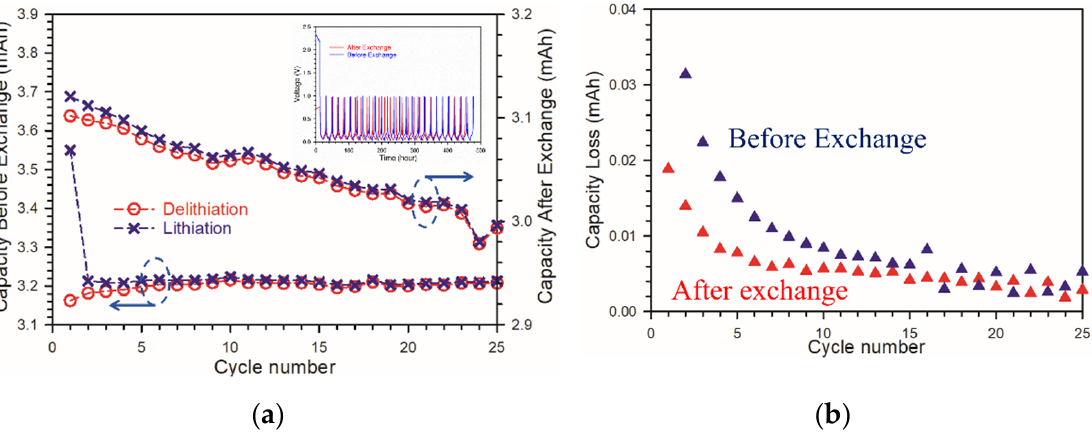
Figure 3. ( a ) Lithiation/delithiation capacity as a function of cycle before and after isotopic exchange (inset: cycling voltage profile), ( b ) Cumulative capacity loss as a function of cycle before and after isotopic exchange.